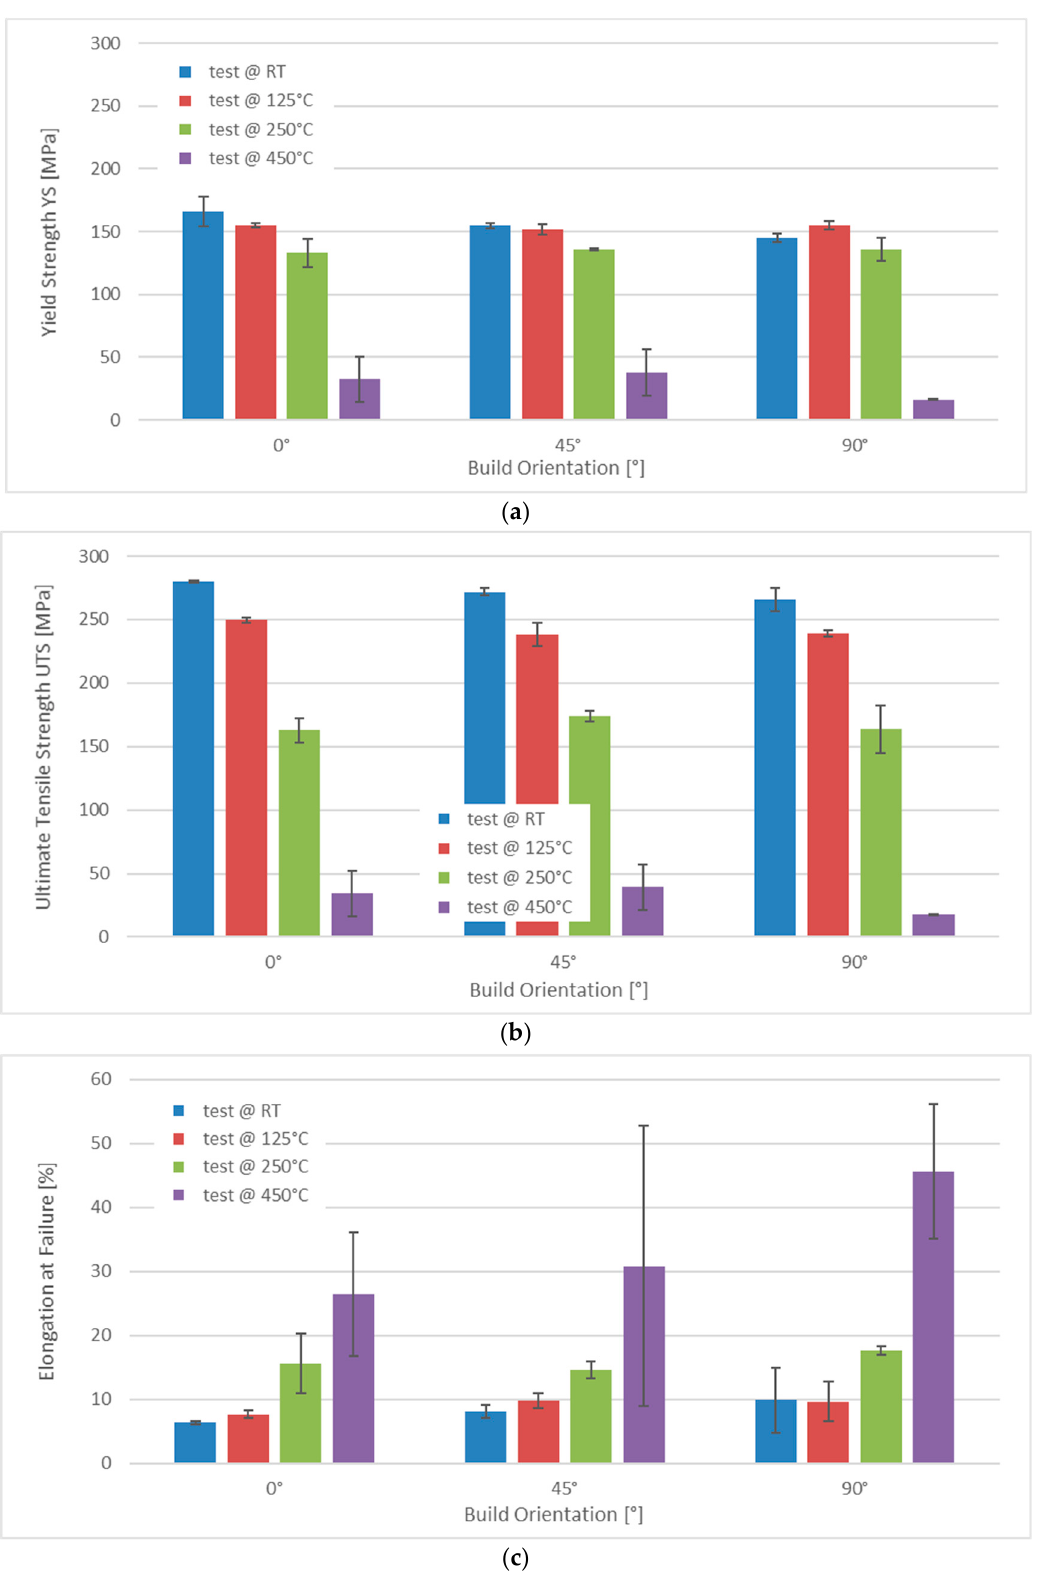
Figure 5. Overview of results of tensile tests performed at room temperature (RT), 125, 250 and 450 °C for three different build orientations, namely polar angles of 0°, 45° and 90°: ( a ) yield strength, ( b ) ultimate tensile strength and ( c ) elongation at failure.